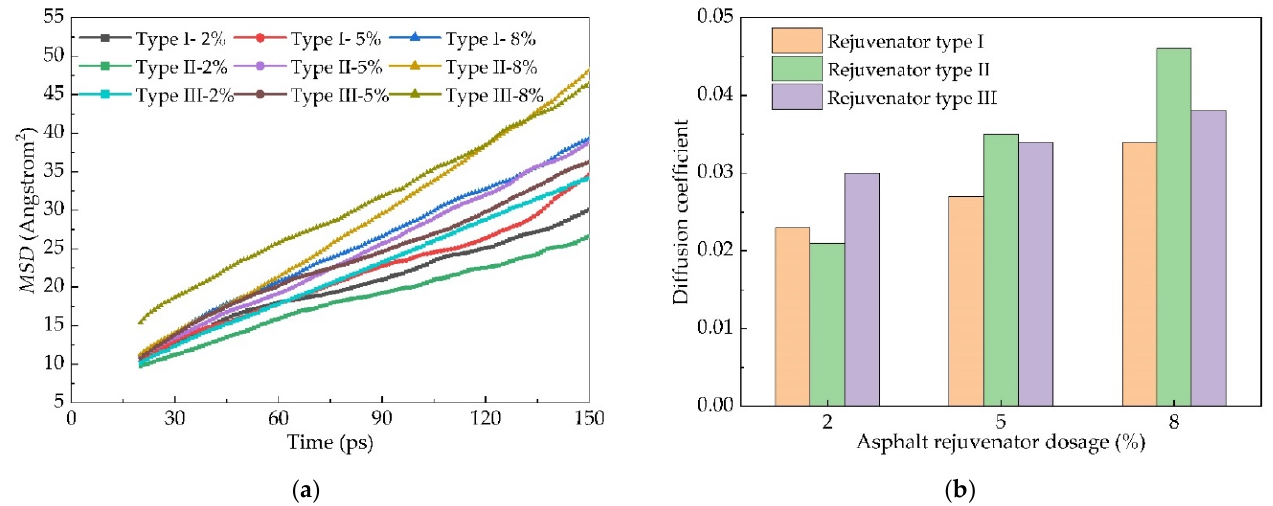
Figure 10. MSD of different rejuvenators and their diffusion coefficient: ( a ) the dependence of MSD as a function of time and ( b ) the dependence of diffusion coefficient as a function of rejuvenator dosage.